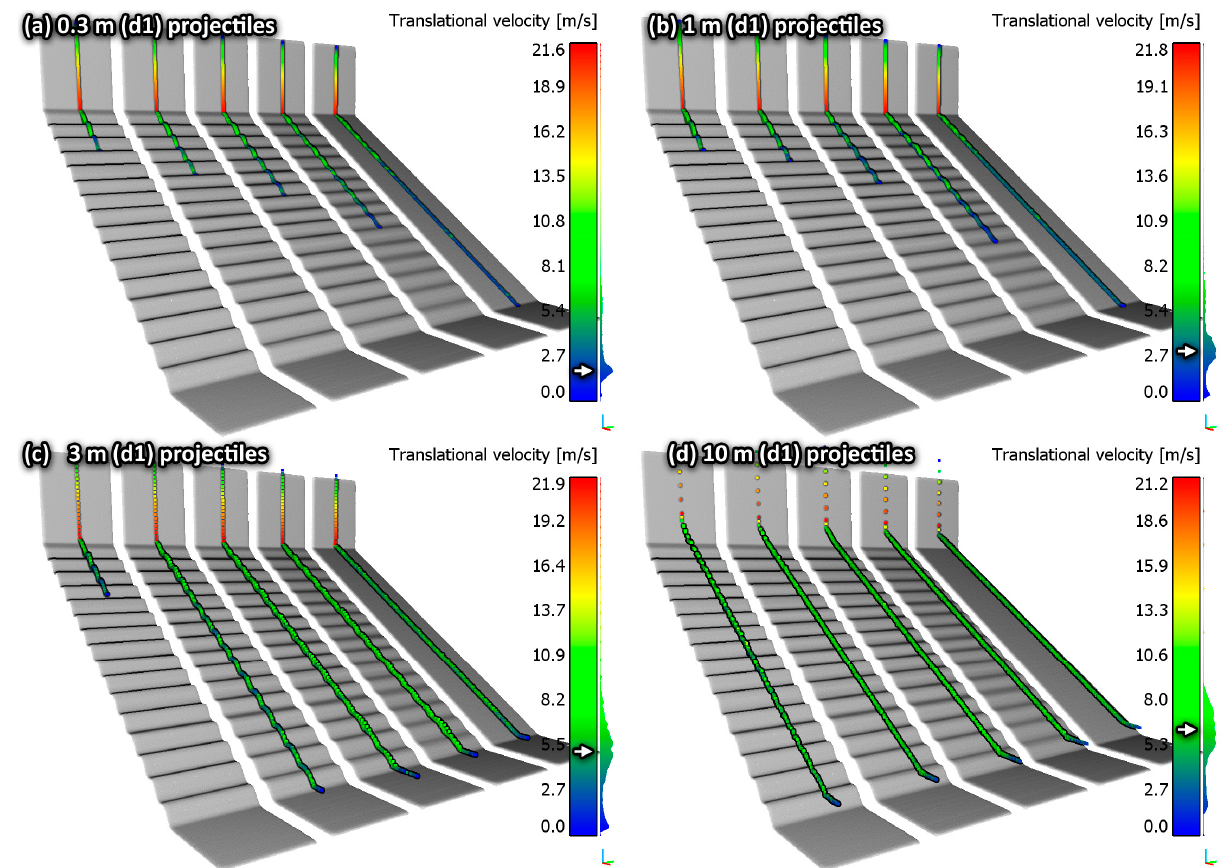
Figure 18. Centerline of the simulated rockfalls (10 per slope) for rocks of different sizes on the artificial slopes of the first site. They are colored based on their translational velocities. The translational velocities increase as the size of the falling rocks increases, which is highlighted on the histograms next to the scale bars with the white arrows. Additionally, the centerline of the trajectories is properly offset to the terrain in relation to the radius of the different rock.